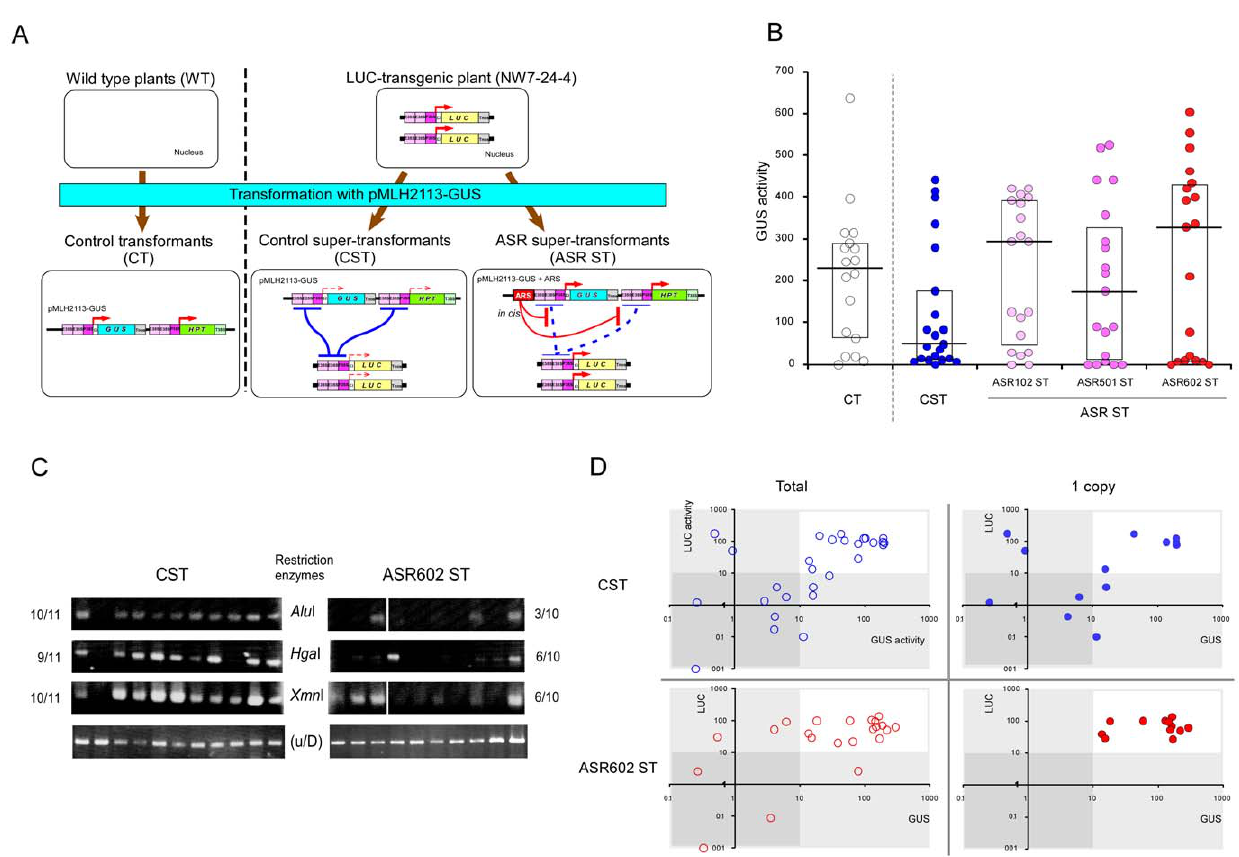
Figure 2. Anti-silencing activity of ASR candidates in preventing trans -TGS caused by interaction between CaMV 35S promoters. ( A ) Schematic representation of strategy to test if ASR candidates can prevent trans -TGS caused by increasing copy number of the same promoter. See text for details. The CT plants (T 0 generation) were regenerated from primary transformed leaves of wild type plant ‘‘Samsun NN’’. The ST and ASR ST plants (ST 0 generation) were regenerated from primary supertransformed leaves of the LUC -transgenic tobacco plant, ‘‘NW7-24-4’’ [15]. ( B ) Prevention of trans -TGS by ASR candidates. The effects of ASRs on expression of the GUS gene driven by the 35S promoter (P35S) were examined. GUS activities of control plants (CT and CST) and supertransformants with one of the ASR candidates (ASR ST) are shown. Boxes show the range of the 25–75th quartiles of the data; the horizontal bars in the boxes present the median value of each group. GUS activity, 4-MU nmol mg protein –1 min –1 . 4-MU , 4- methylumbelliferone. ( C ) DNA methylation status of enhanced P35S promoters flanked (or not) with ASR602 in the GUS construct expressed in the P35S-dosage-dependent TGS system. The promoter regions of the GUS construct, pMLH2113-GUS, in control supertransformants (CST) and ASR supertransformants (ASR602 ST) were examined (Figures 2A and S4). Each lane represents the same supertransformant. The numbers to the right and left of the slashes represent total plants and plants harboring the methylated promoter, respectively. u/D , undigested DNAs. ( D ) Prevention of trans - TGS by ASR602. The activity of the pre-existing P35S:: LUC insert was plotted against activity of the supertransformed P35S:: GUS gene for CSTs and ASR602STs. LUC activity, photon m g protein –1 sec –1 . Note that the scales are logarithmic. Total , all plants examined; 1 copy , plants harboring a single copy of the P35S:: GUS transgene. We measured the copy number of P35S:: GUS to select super- Total), there was a significant positive correlation between transformants containing only a single copy of P35S:: GUS P35S:: GUS and P35S:: LUC expression levels (Table S3); most of (Figure 2D, right, 1 copy) from all the plants examined the supertransformants with low GUS expression also showed (Figure 2D, left, Total). To determine the copy number of extremely low LUC expression, indicating that supertransforma- P35S:: GUS in the supertransformants, gene-dosage ratios of GUS / tion with P35S:: GUS induced trans- TGS of P35S:: LUC (Figure 2D, LUC were measured with real-time PCR using genomic DNAs top left, CST/Total). We then examined whether TGS of isolated from the supertransformants (Table S1). We re-plotted P35S:: LUC is caused when a P35S:: GUS flanked with ASR602 is GUS and LUC expression data of the selected supertransformants supertransformed. In supertransformants containing ASR602 (Figure 2D, right, 1 copy). In supertransformants without ASR602 (ASR602 ST), a very small number of plants showed low (Figure 2D, top right, CST/1 copy), about half the plants (7/13) expression of P35S:: GUS and/or P35S:: LUC transgenes showed low expression levels of the pre-existing P35S:: LUC and/ (Figure 2D, bottom left, ASR602 ST/Total), suggesting that or the supertransformed P35S:: GUS . In supertransformants with supertransformation with the P35S:: GUS containing ASR602 ASR602 (Figure 2D, bottom right, ASR602 ST/1 copy), no plants suppresses trans -TGS of the P35S:: LUC as a result of preventing (0/12) expressed low levels of the P35S:: LUC and/or P35S:: GUS TGS of the P35S:: GUS . transgenes. These results show that ASR602 effectively repressed Plants harboring multiple copies of a transgene tend to have complicated transgenic loci [18] and/or undergo PTGS [2,15].